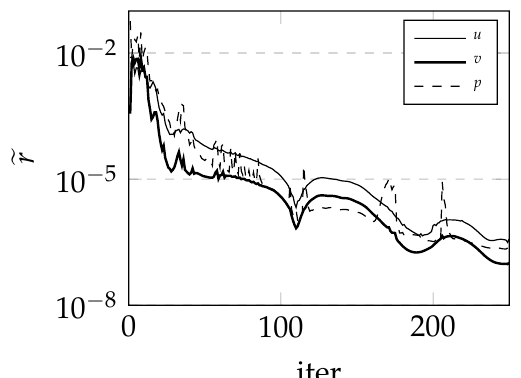
Figure 15. Convergence characteristics of flow equations.